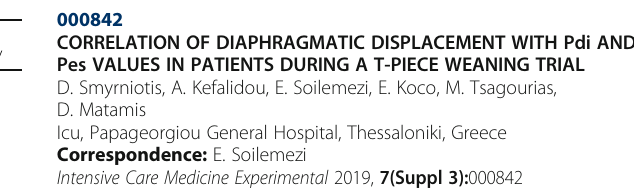
Table 1 (abstract 000805). Data shown as median with interquartile range for epithelial necrosis and necroptosis markers. Comparisons were made between hyper-inflammatory vs hypo-inflammatory groups using Mann Whitney U. N = 15 per group. (**p<0.001 * p<0.02) Epithelial Necrosis Cytokeratin-18